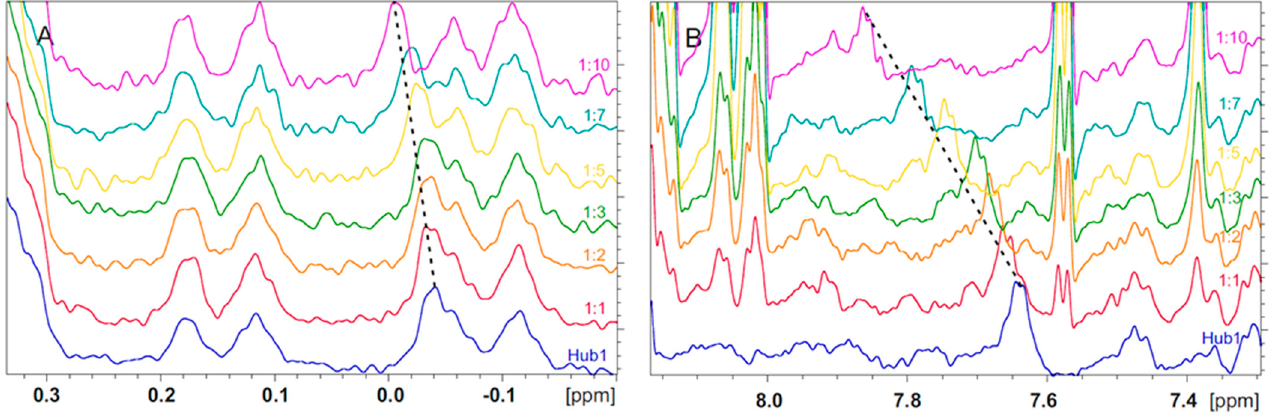
Figure 2. 1 H NMR titration experiment of Hub1 with peptide-14. ( A ) Aromatic region of the